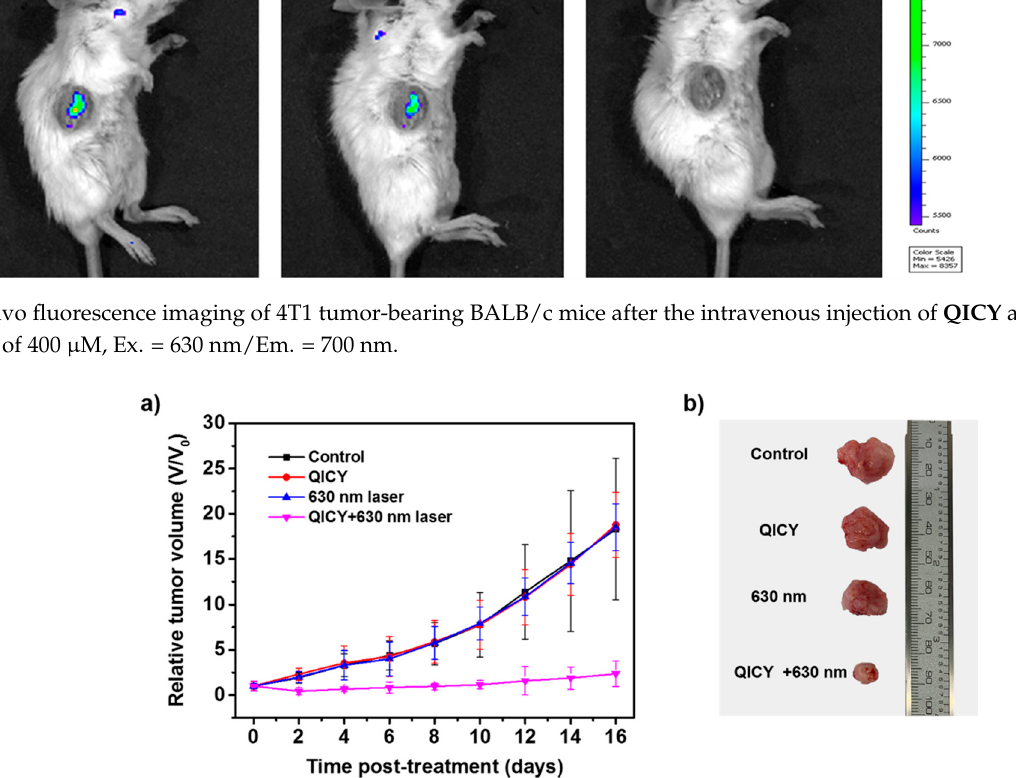
Figure 10. Comparison of the relative tumor volume after treatments: ( a ) Relative tumor volume of the mice in the control, QICY, 630 nm laser irradiation, and QICY + 630 nm laser irradiation groups after the different treatments ( n = 5 per group); ( b ) Representative tumor images in the different treatment groups on day 16 after treatment.